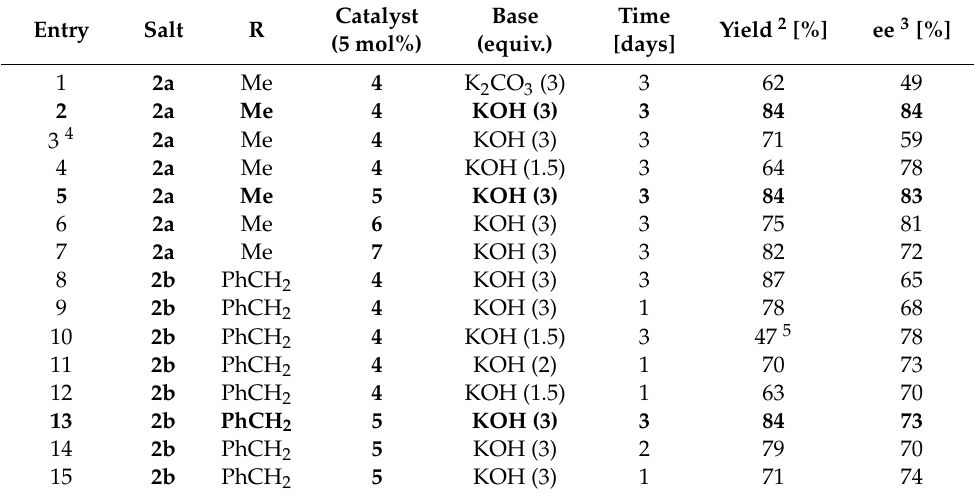
Table 1. Screening of the reaction conditions for PT-catalyzed stereoselective α -amidoalkylation reaction. 1